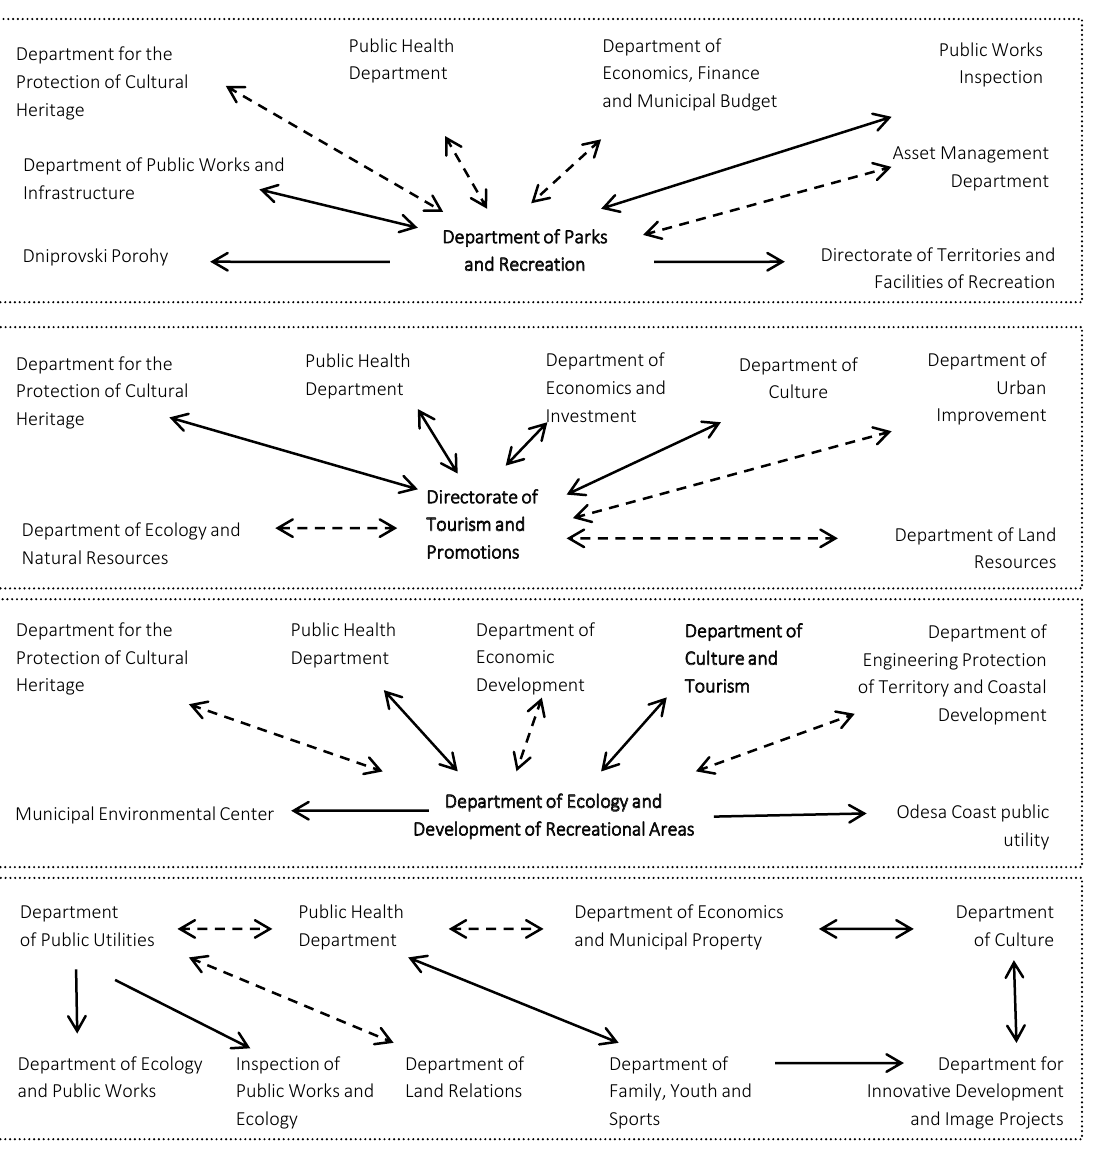
Figure A1. Wellness and recreation related departments within the municipal government structures of Dnipro, Kyiv, Odesa, and Kharkiv (from up to